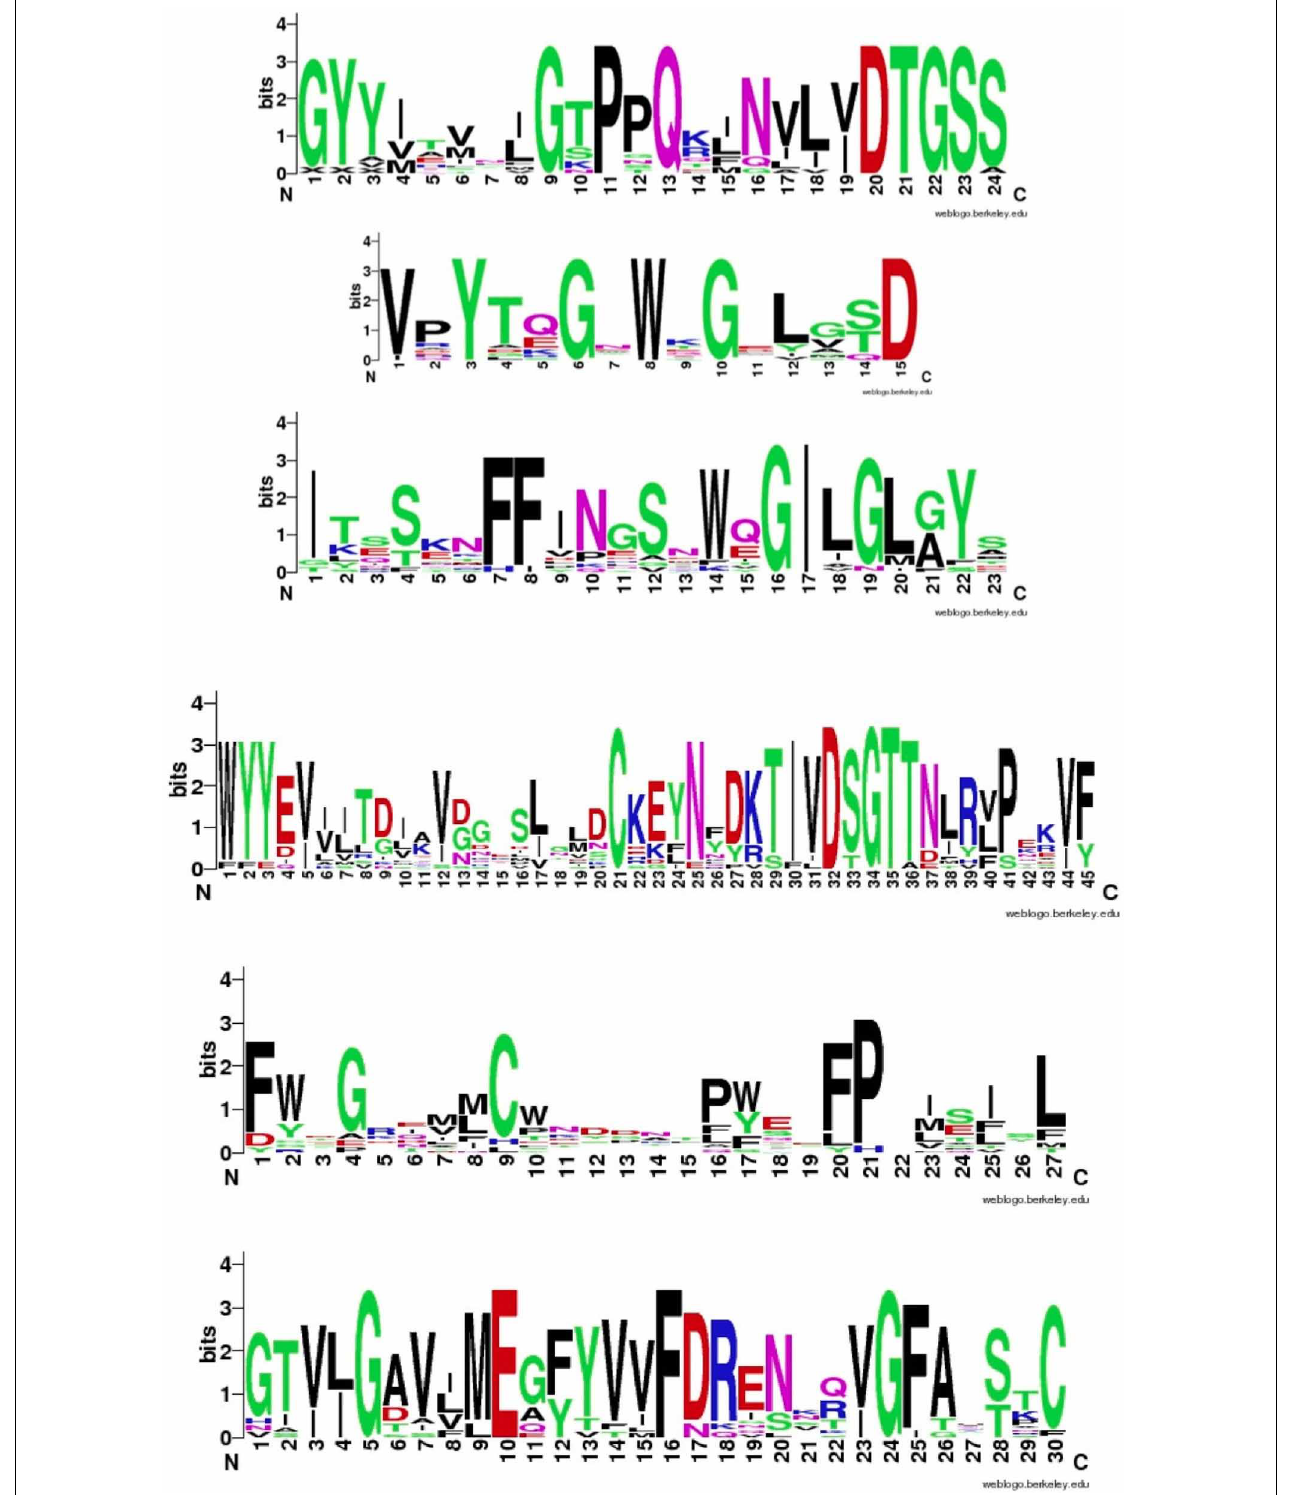
FIGURE 5 | Sequence Logos for the six conserved UrBACE blocks in N-terminal to C-terminal order (with spacing shown in Table 2). Residue letter height is an index of conservation.